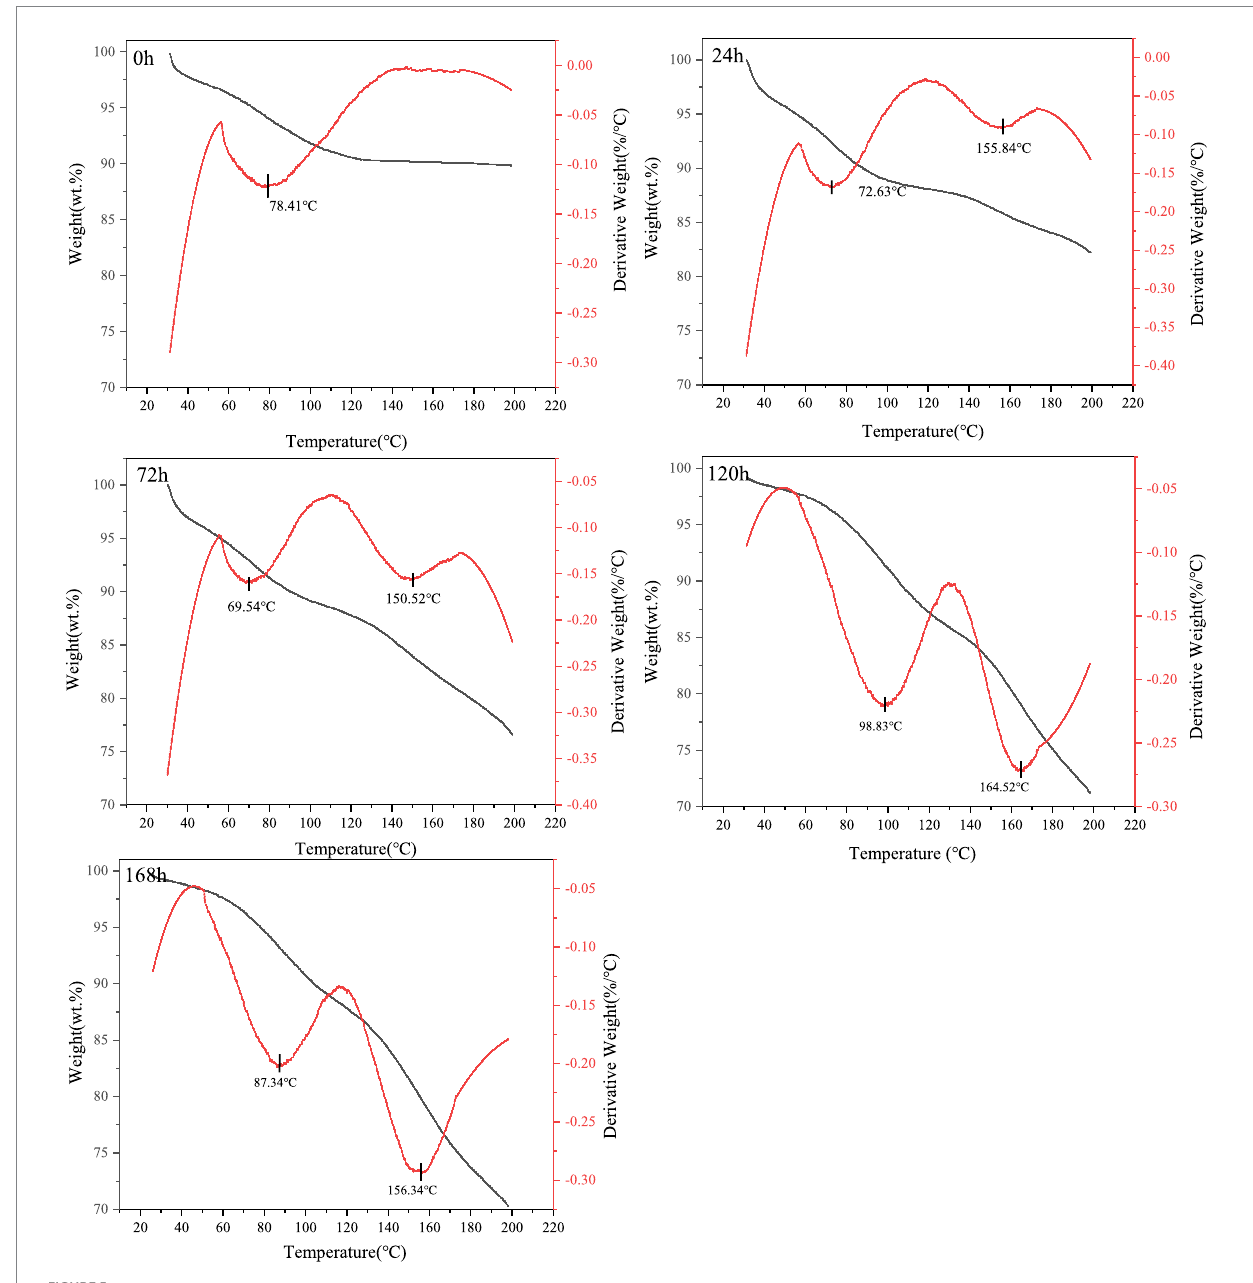
FIGURE 5 Thermo gravimetric analysis of fermentation substrate at different fermentation